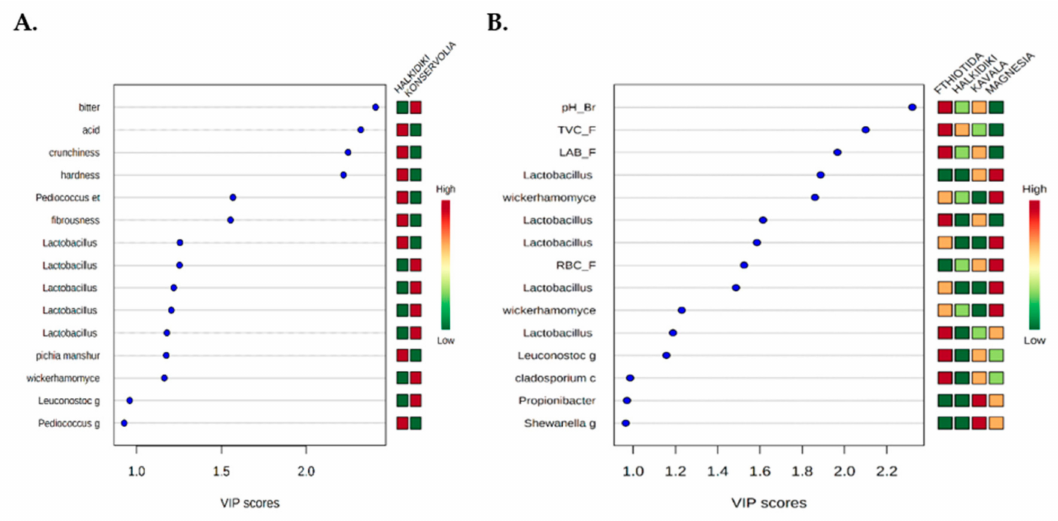
Figure 9. Most influential parameters of the olive samples based on the VIP scores from the PLS-DA analysis at ( A ) cultivar and ( B ) geographical origin